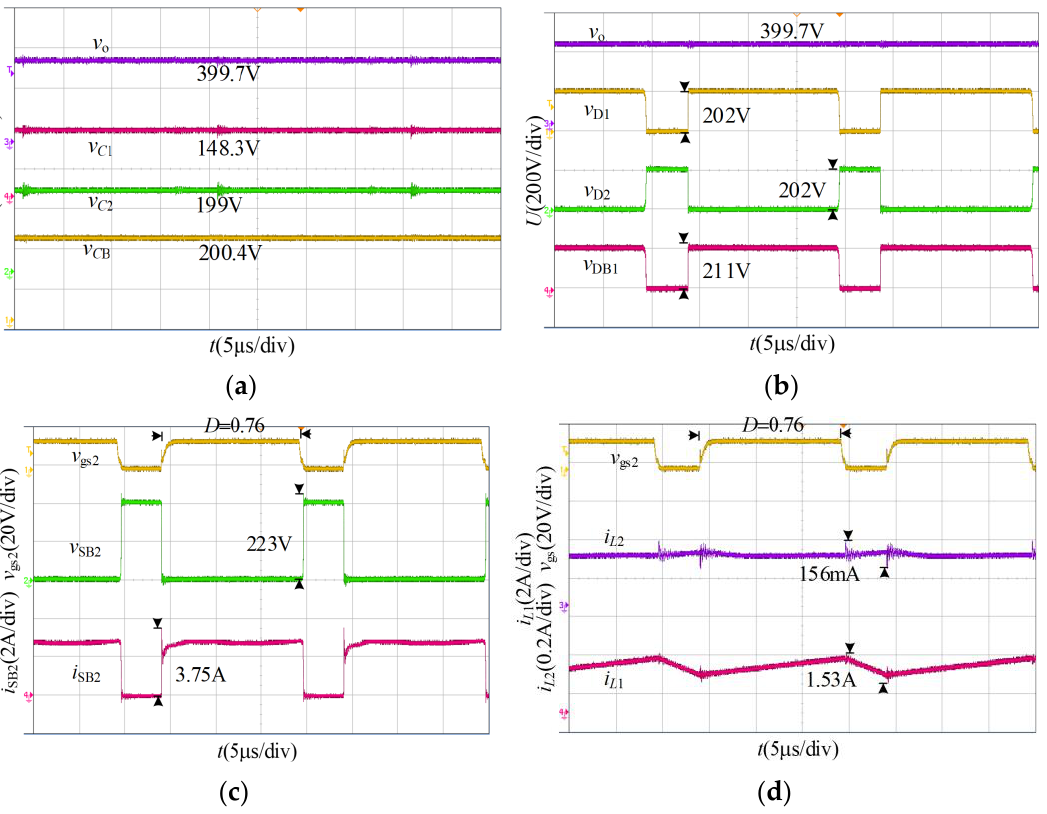
Figure 15. The steady waveforms of the proposed converter in step-up mode: ( a ) v o , v C1 , v C2 , v CB ; ( b ) v o , v D1 , v D2 , v DB1 ; ( c ) v gs2 , v SB2 , i SB2 ; ( d ) v gs2 , i L1 , i L2 .